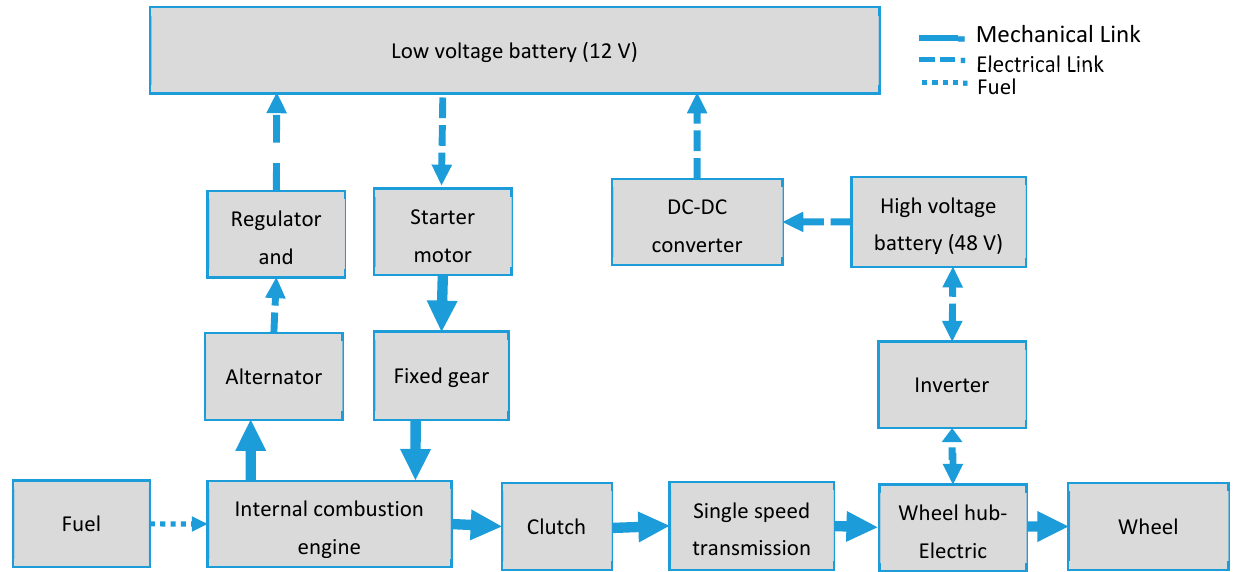
Figure 1. Powertrain architecture of the hybrid two-wheeler.